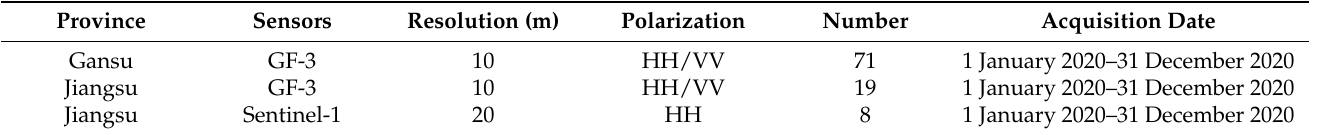
Table 3. The information of the GF-3 and Sentinel-1 SAR data of the study